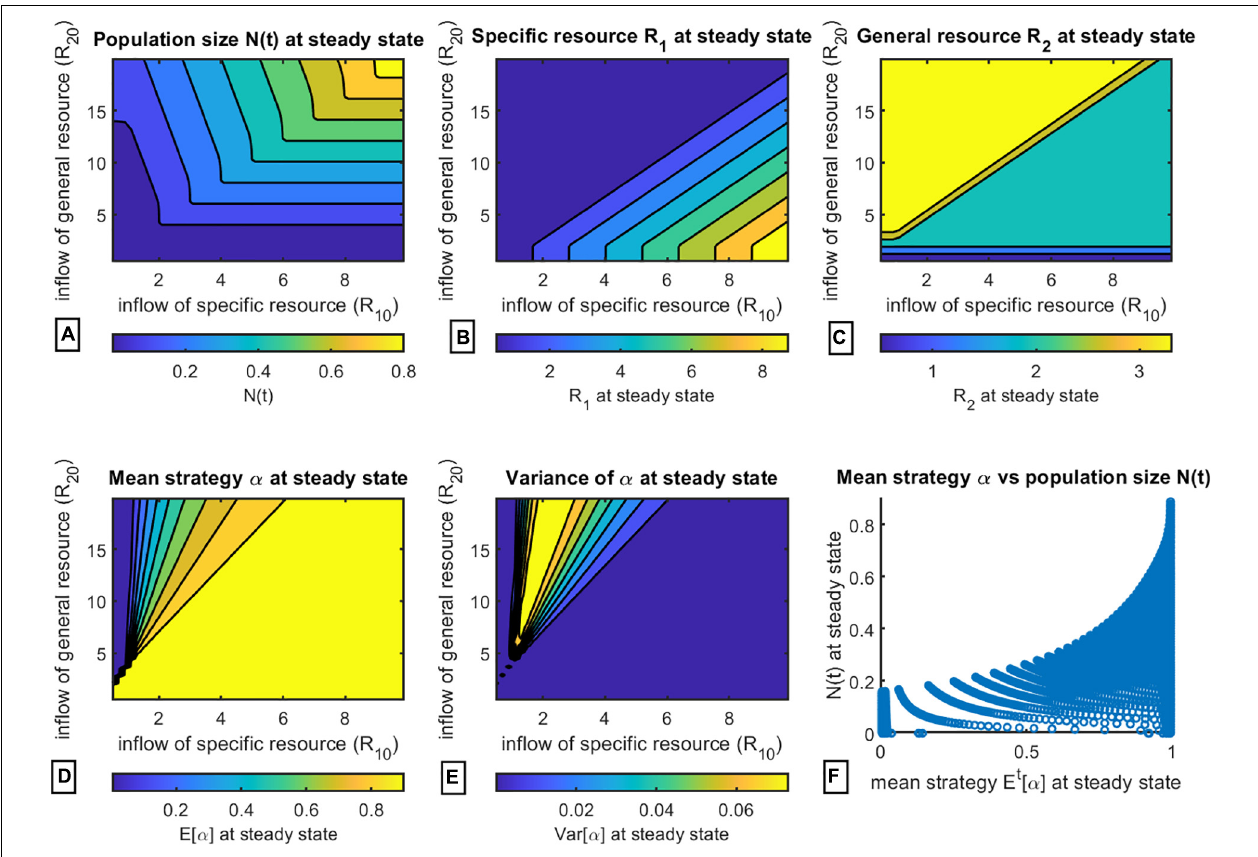
FIGURE 4 | Evaluation of population composition and equilibrium values at steady state subject to variation of resource inflow rates. (A) population size N(t); (B) equilibrium levels of specific resource R 1 ; (C) equilibrium levels of general resource R 2 ; (D) mean strategy E t [ α ] ∈ [ 0 , 1 ] ; (E) variance Var t [ α ] ; (F) mean strategy E t [ α ] vs. population size N ( t ) at steady